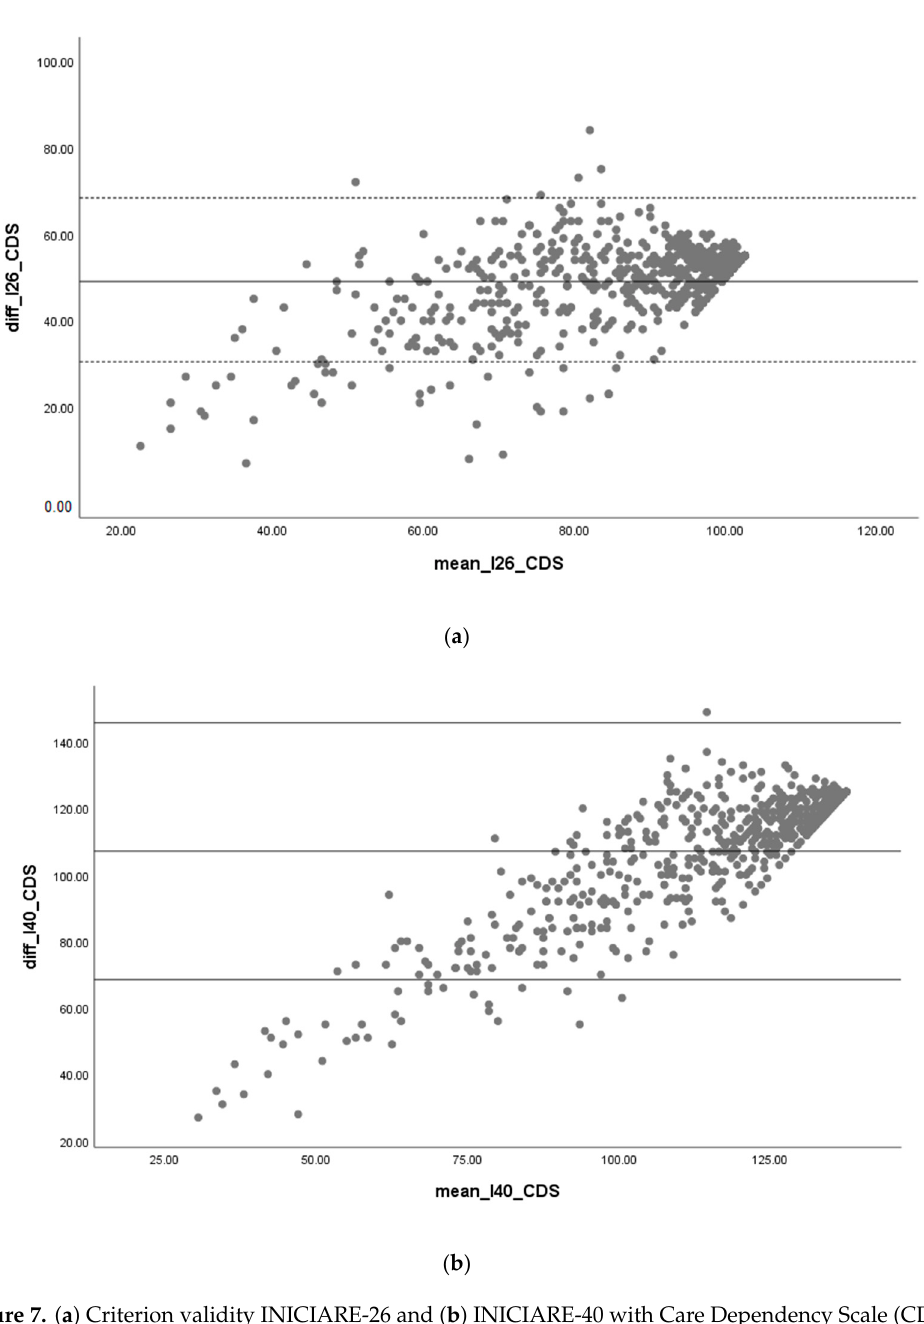
Figure 7. ( a ) Criterion validity INICIARE-26 and ( b ) INICIARE-40 with Care Dependency Scale (CDS).